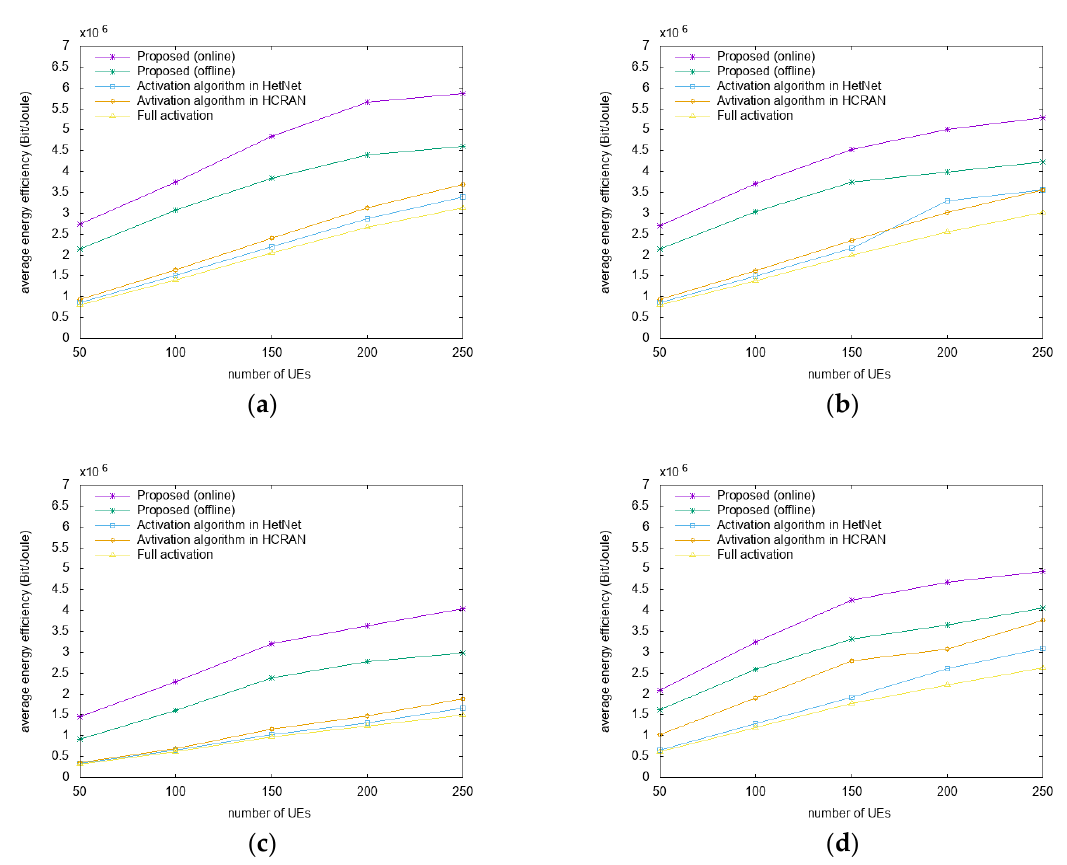
Figure 2. Comparison of energy efficiencies. ( a ) San Francisco and ( c ) Beijing datasets with Gaussian distributions; ( b ) San Francisco and ( d ) Beijing datasets with uniform distributions.